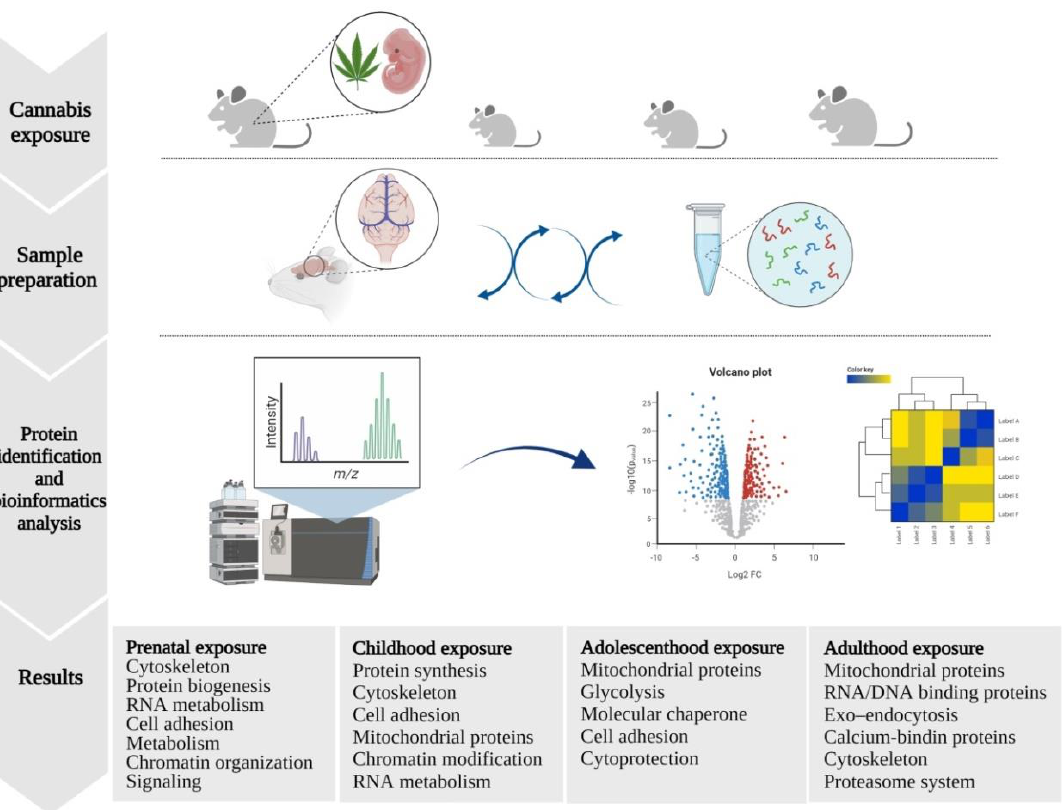
Figure 3. Proteomics workflow to identify differentially expressed proteins (DEPs), their function and associated pathways in the brain of mice/rats, following exposure to THC at different life stages.